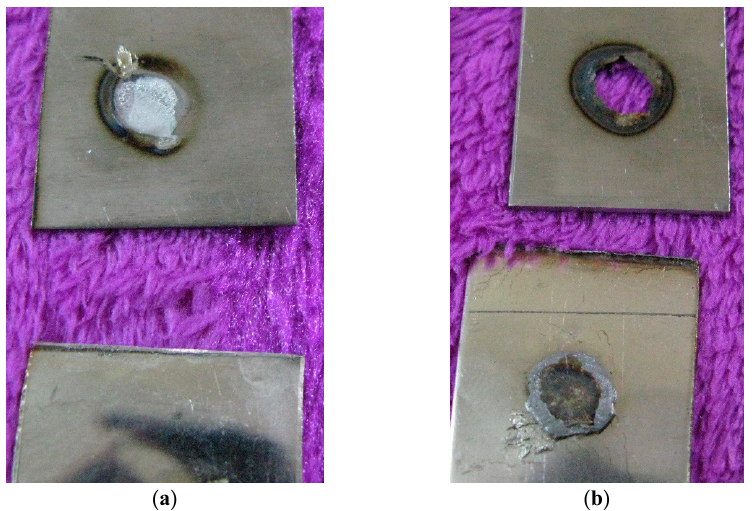
Figure 4. Two failure modes after tensile shear tests: ( a ) interfacial mode and ( b ) pullout mode.